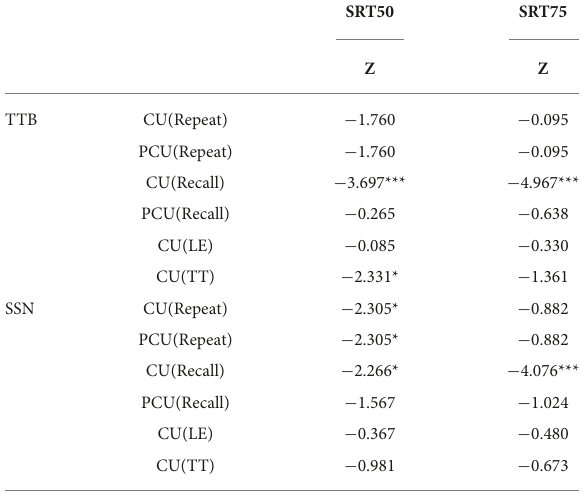
TABLE 4 Differences between two age groups in SRT50 and SRT75.